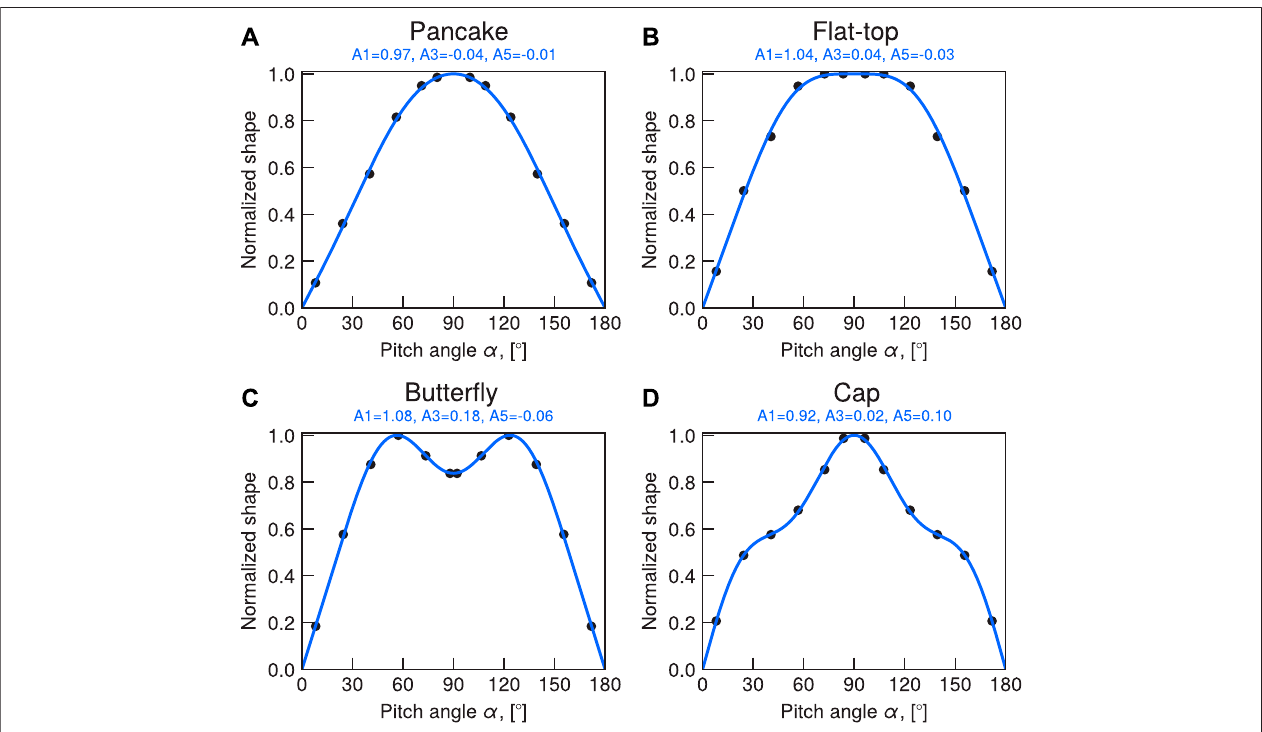
FIGURE 1 | Examples of the fi tted pancake (A) , fl at-top (B) , butter fl y (C) and cap (D) equatorial PADs, normalized using equation 2. The dots show normalized MagEIS observations and the solid lines give fi tted